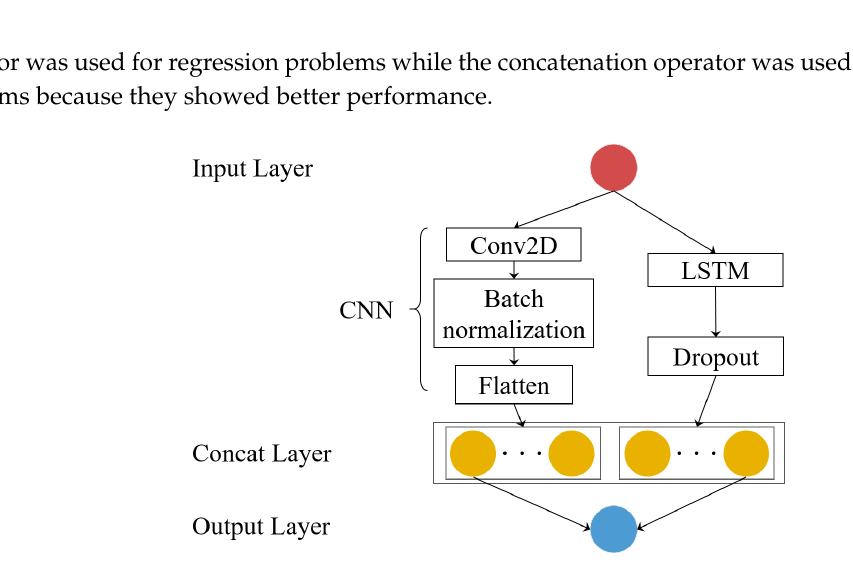
Figure 9. Our CRNN model (a combination of CNNs and RNNs) that combines the results of CNN and LSTM models using a concatenation operator. The Conv2D block represents the 2D convolution layer in Figure 7 and the LSTM block represents the LSTM model discussed in Secion 3.2.2.